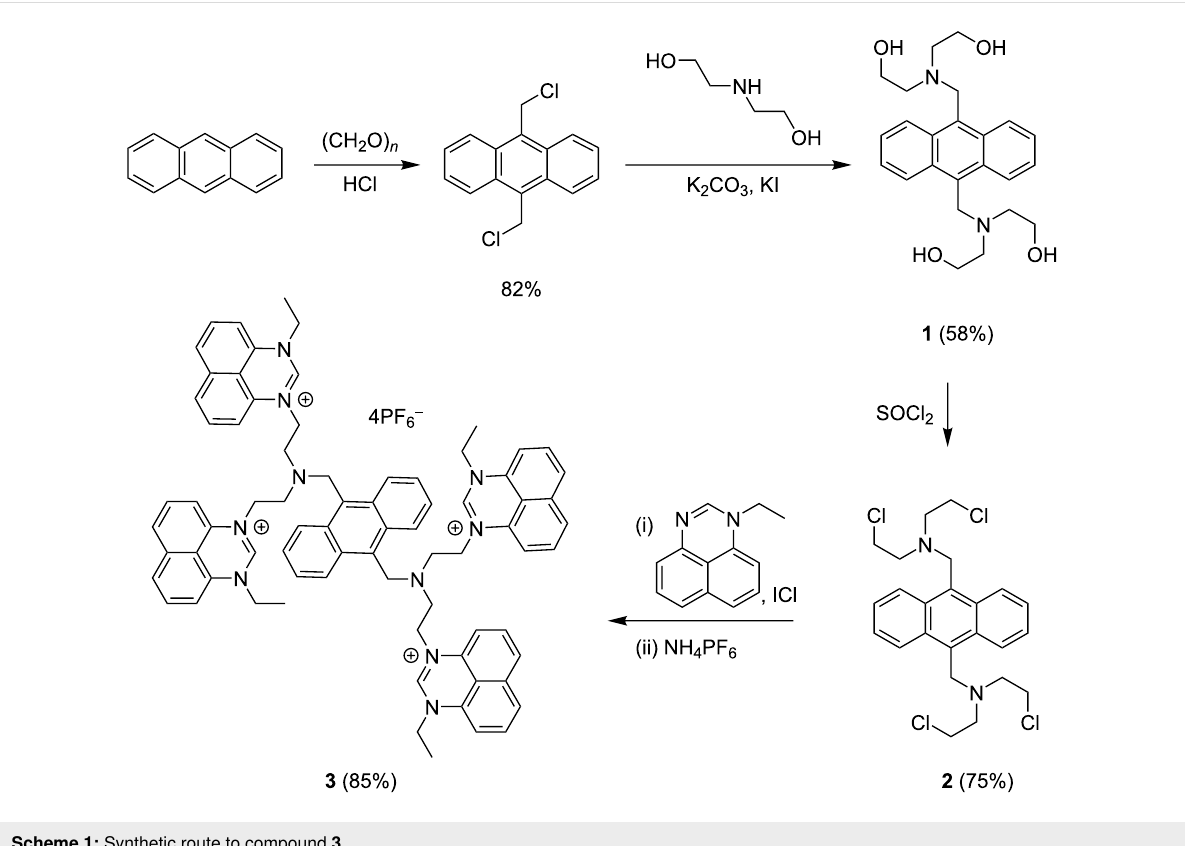
Scheme 1: Synthetic route to compound 3